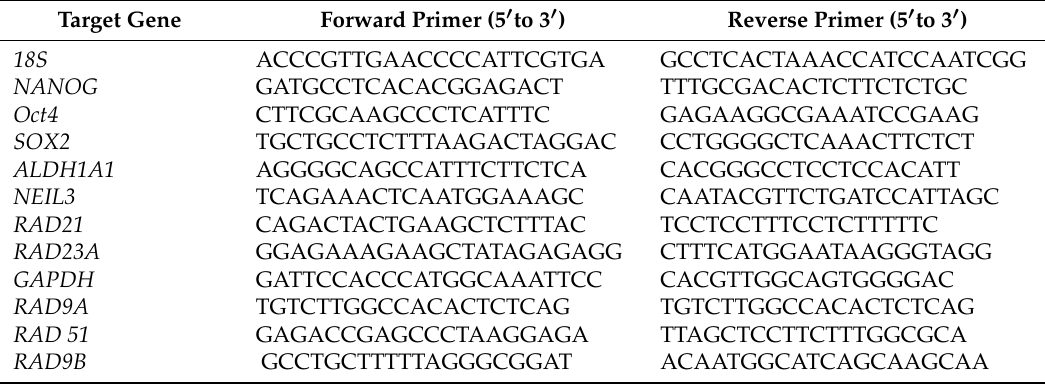
Table 1. Real-time PCR